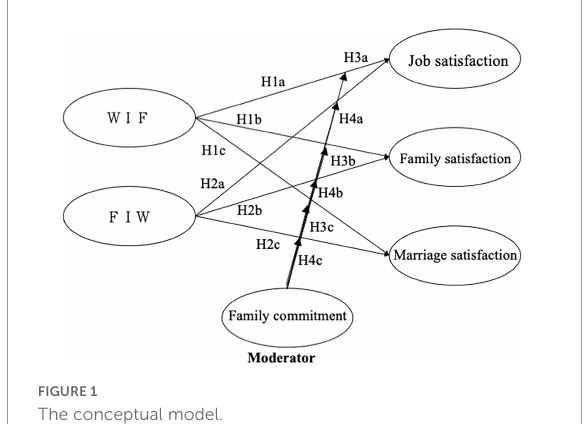
FIGURE1 The conceptual